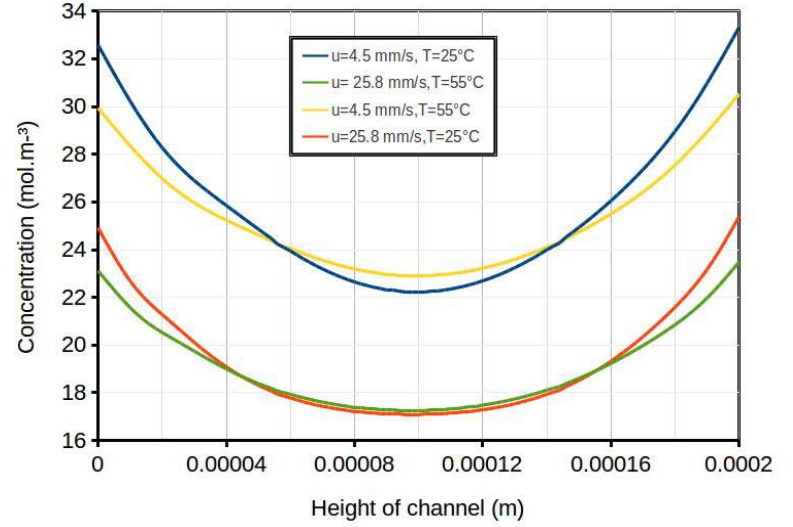
Figure 6. Concentration profiles versus the height of the channel (the a − − b cross-section in Figure 5a) at X = 0.0108 m from the inlet of the dilute channel at two different inlet average velocities (u = 4.5 and 25.8 mm ) and T = 25 ◦ C and T = 55 ◦ C, resulting in four different Re numbers: Re = 1, 1.8, 5.7, and 10. s